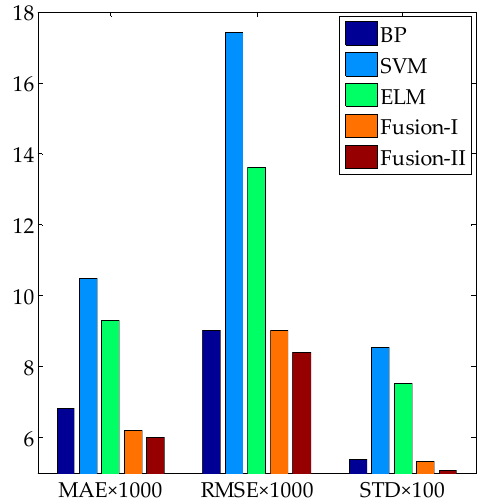
Figure 6. Comparison of different performance indicators of each model.